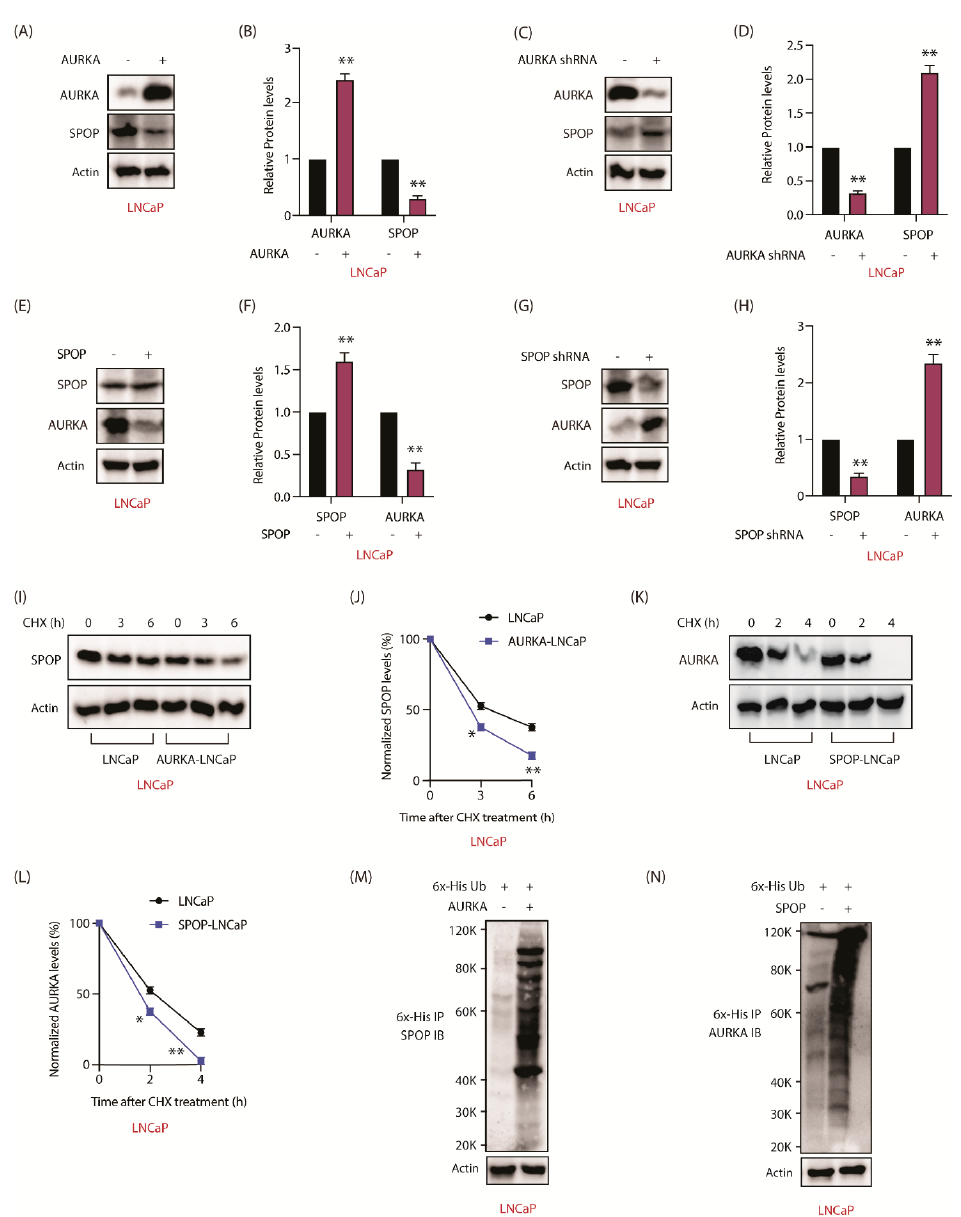
Figure 7. AURKA and SPOP are involved in a negative feedback loop in LNCaP cells as well. ( A ) AURKA negatively regulates SPOP in LNCaP cells. ( B ) Histogram showing change in SPOP levels with AURKA overexpression. The data are presented as mean ± SEM obtained from three independent experiments. ** p < 0.01 vs. LNCaP control cells. ( C ) AURKA silencing increases SPOP in LNCaP cells. LNCaP cells were infected with either scrambled shRNA or shRNA targeting AURKA lentivirus, followed by IB. ( D ) Histogram shows change in SPOP levels with AURKA knockdown. The data are presented as mean ± SEM obtained from three independent experiments. ** p < 0.01 vs. LNCaP control cells. ( E ) Overexpression of SPOP decreased the levels of AURKA in LNCaP cells. ( F ) Histogram shows change in AURKA levels with SPOP overexpression. The data are presented as mean ± SEM obtained from three independent experiments. ** p < 0.01 vs. LNCaP control cells. ( G ) SPOP silencing increases AURKA levels in LNCaP cells. ( H ) Histogram shows change in AURKA levels with SPOP knockdown. The data are presented as mean ± SEM obtained from three independent experiments. ** p < 0.01 vs. LNCaP control cells. ( I ) AURKA increases SPOP degradation in LNCaP cells. LNCaP and AURKA-LNCaP cells were treated with cycloheximide (10 µ M) for 3 and 6 h and SPOP levels analyzed. ( J ) Graphical representation of SPOP degradation rate in LNCaP cells. The data are presented as mean ± SEM obtained from three independent experiments. * p < 0.05, ** p < 0.01 vs. LNCaP control cells. ( K ) SPOP increases AURKA degradation in LNCaP cells. ( L ) Graphical representation